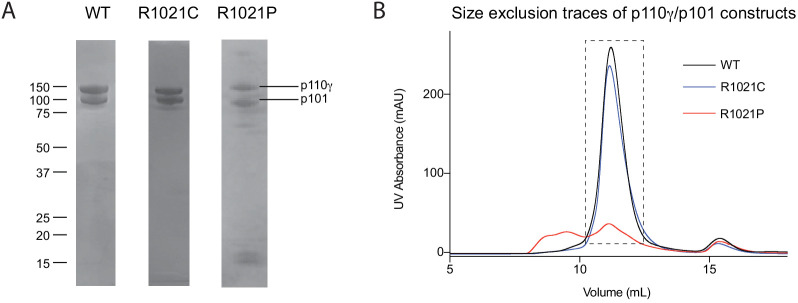
Purification of mutated p110γ / p101 complexes.(A) SDS-page analysis of the final complexes after size exclusion chromatography. The location of size markers are shown on the left. (B) Gel filtration elution of the wild type and mutant p110γ/p101 complexes on a Superdex 200 10/300 GL Increase column.